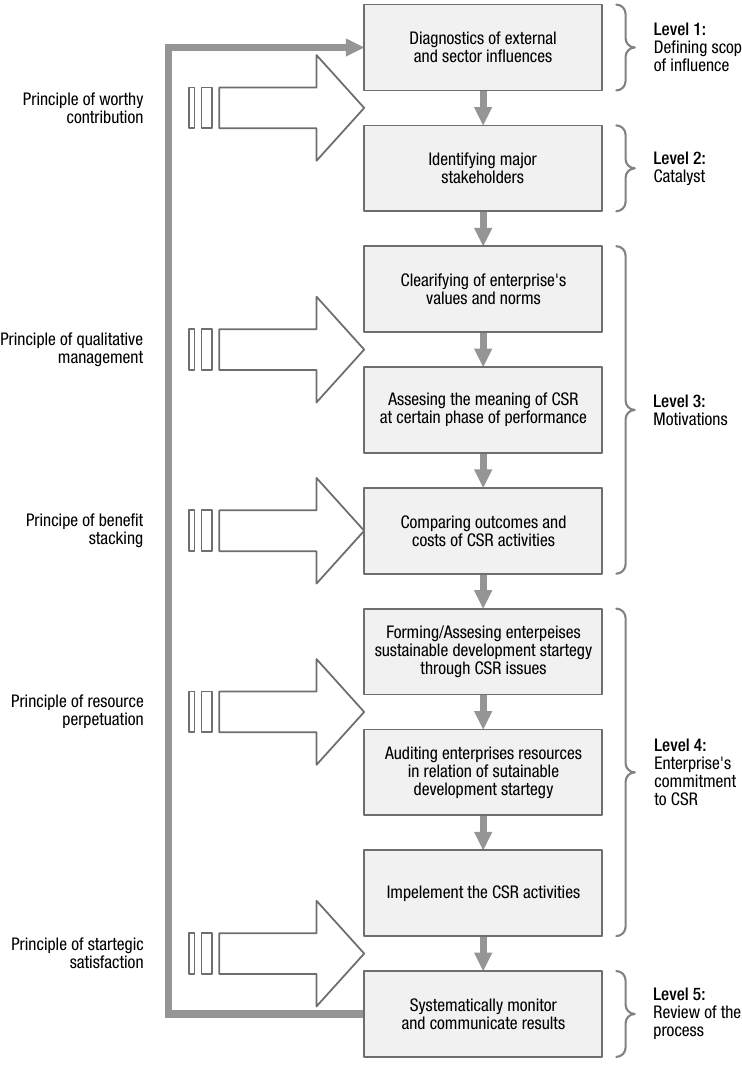
Fig. 1. Framework of diagnosing enterprise’s commitment to corporate social responsibility seeking to sustain Source : Valackienė et al. (2012: